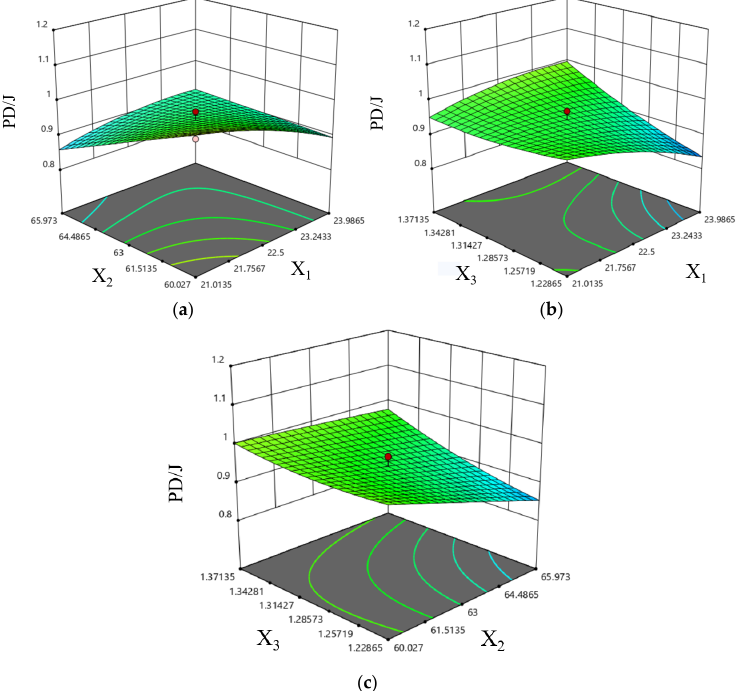
Figure 12. Effect diagram of the interaction between-cutting power and consumption: ( a ) the interaction between the cutting-edge angle and the cutting angle on the power consumption, ( b ) the interaction between the cutting-edge angle and the reciprocating speed on power consumption, and ( c ) the interaction between the cutting angle and the reciprocating speed on the power consumption.